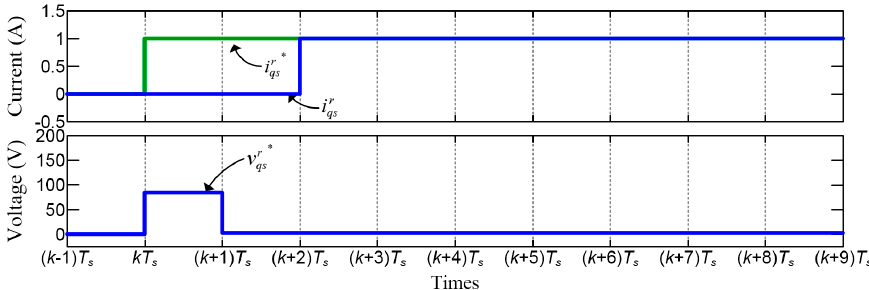
Figure 8. The simulated q -axis current, current command, and voltage command when the current command steps from 0 A to 1 A.